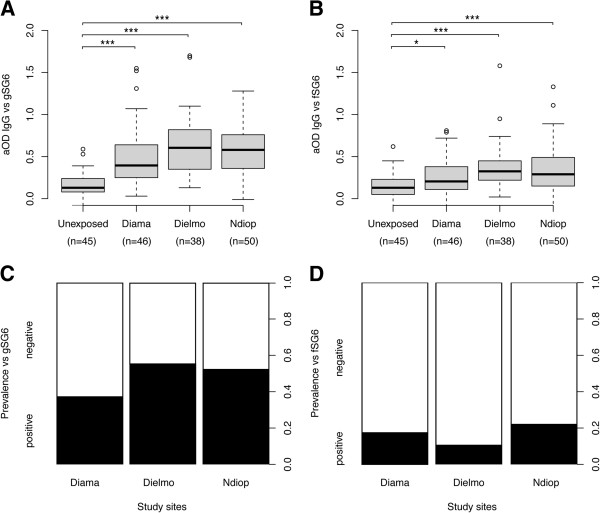
The IgG response and prevalence to gSG6 and fSG6 according to the level of mosquito bites and Anopheles populations (i.e.,proportion of mosquito species). Box plots of aOD values from un-exposed (n = 45) and exposed (Diama, n = 46; Dielmo, n = 38 and Ndiop, n = 50) individuals to gSG6 (A) and fSG6 (B) proteins. Antibody responses are represented by aOD: the mean OD value of wells with recombinant salivary proteins minus the mean OD value of wells with coating buffer. The box plots display the median aOD value, 25th and 75th percentile. The whiskers indicate the 90th and 10th percentiles and the dots indicate the outliers. The P value was determined according to a Mann–Whitney U test (*, p <0.05; **, p <0.01; ***, p <0.001). The seroprevalence to gSG6 (C) and fSG6 (D) proteins in the four sites. The cut-off value for seropositivity (the mean aOD ± 3 standard deviations) was defined at 0.55 for gSG6 and 0.59 for fSG6, based on the IgG reactivity of sera from individuals living in Marseille that were not previously exposed to An. gambiae s.l. and An. funestus. Individuals showing aOD values above the cut-off level for seropositivity were classified as responders. The whiskers denote the 95% CI. The P values were determined by Pearson’s Chi-squared test (*, p <0.05; **, p <0.01; ***, p <0.001).